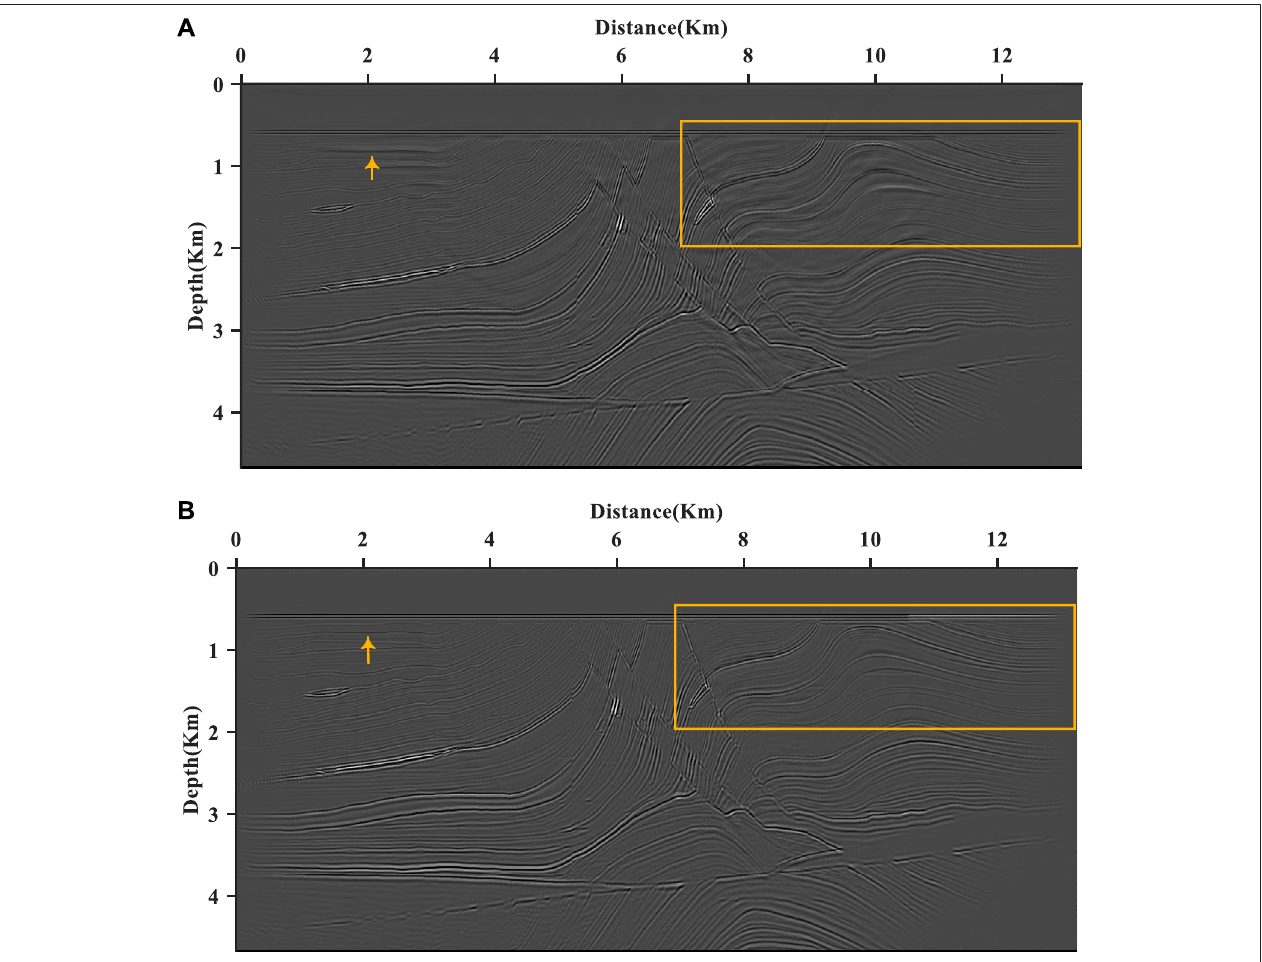
FIGURE 15 | The PP images of the Marmousi 2 model by the scalar imaging condition with the Laplace fi lter (A) and with the pseudo-Laplace fi lter (B) . The two imagesembodythestructuralcharacteristics ofthemodel.TheoverallappearanceofPanelBismoreapparentandeventsintheshallowlayeraremorecontinuousthan those in Panel A. Furthermore, the backscattering noise of Panel A is more serious than that in Panel B.